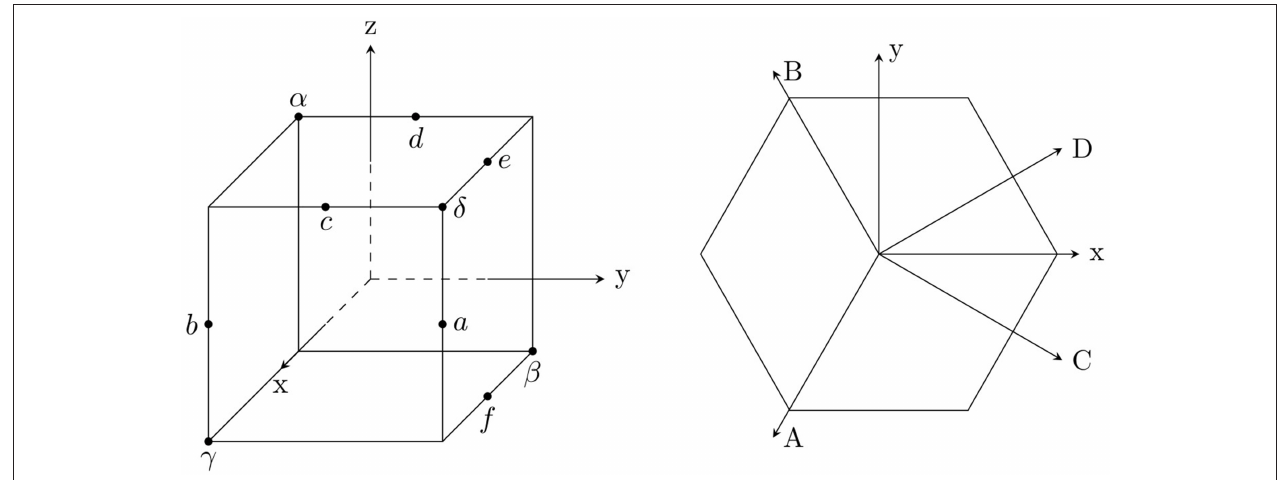
FIGURE 2 | Rotation axes for symmetry elements in Schönflies notation (according to Cornwell